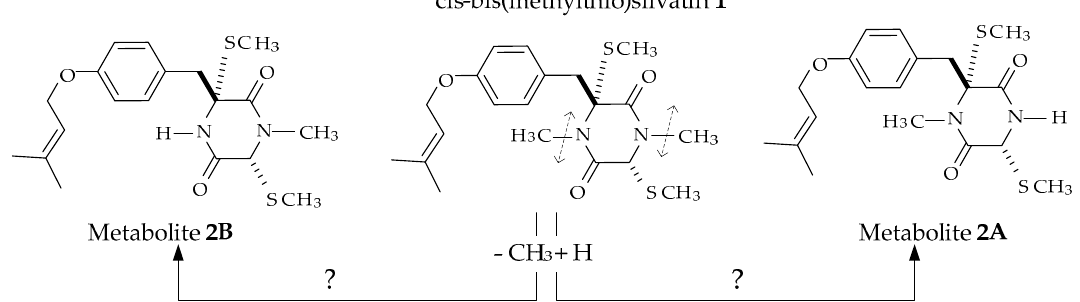
Figure 4. Hypothetical pathways for the conversion of the formula of cis -bis(methylthio)silvatin ( 1 ) to the formula of metabolite 2 in Table 1 .